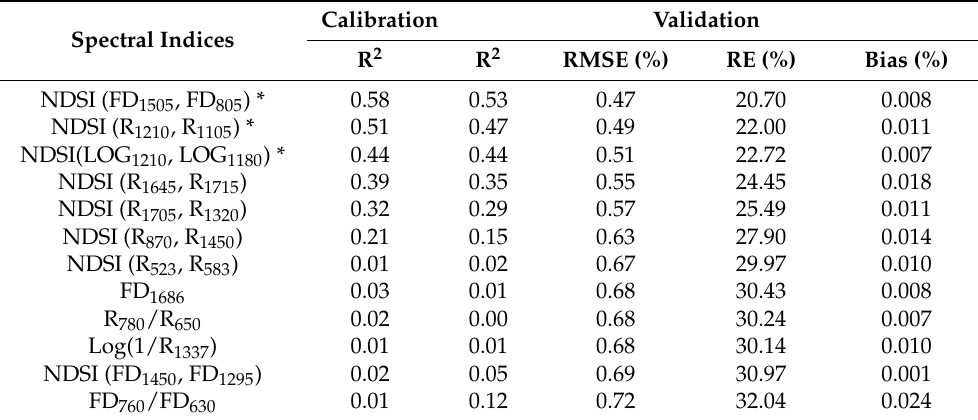
Figure 7. Relationships between rice plant potassium content (PKC) and normalized spectral index (NDSI): NDSI (R 1210 , R 1105 ) ( a ), NDSI (FD 1505 , FD 805 ) ( b ), and NDSI (LOG 1210 , LOG 1180 ) ( c ) using the calibration dataset. R, FD, and LOG represent reflectance, first derivative spectra, and reciprocal logarithm-transformed spectra, respectively. Table 5. Relationship between rice plant potassium content (PKC) and new spectral indices and existing spectral indices using the calibration